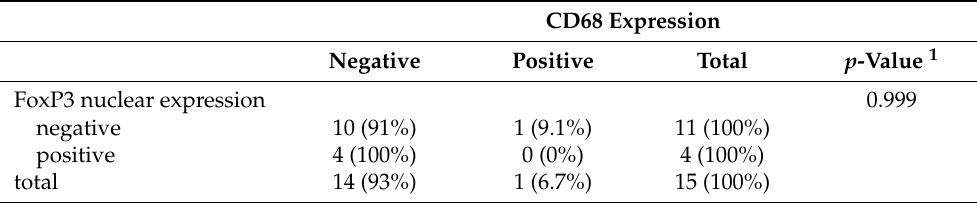
Table 6. Correlation between FoxP3 and CD68 expression in NSCLC